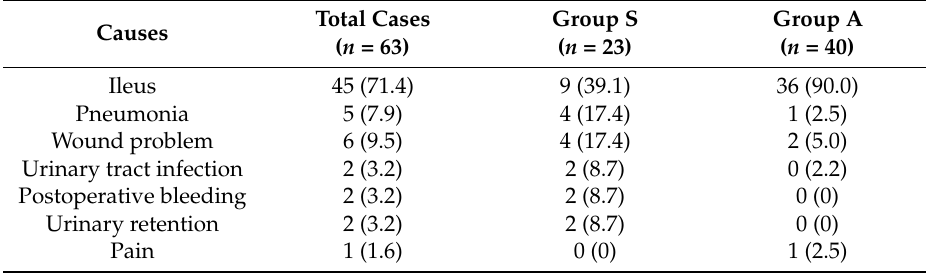
Table 3. Causes of delayed